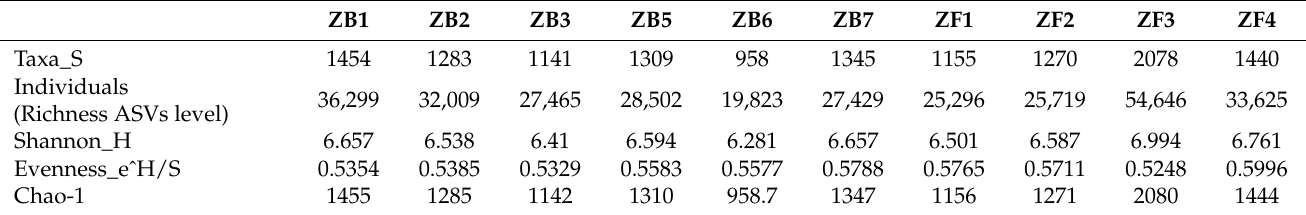
Table 1. Diversity indices calculated on 16S rRNA metabarcoding results using PAST 4.03 software.